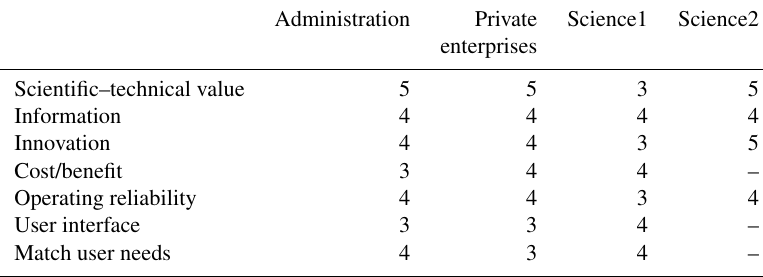
Table 1. Evaluator feedback on the product “Pre-operational Surface Current Fields” (values from 1: bad/low to 5: good/high).